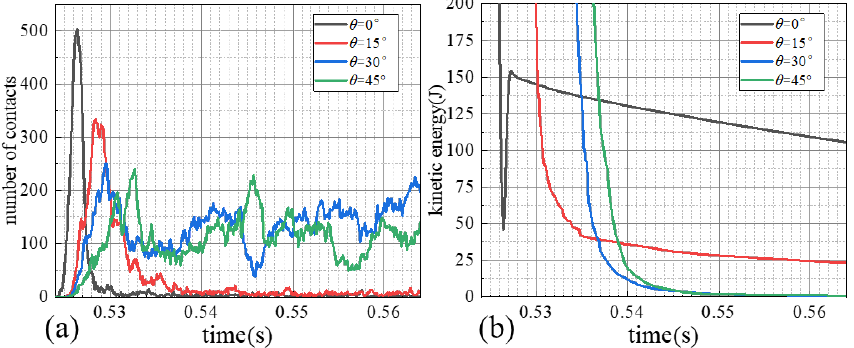
Figure 4. DEM simulation statistical results of the particle system under different baffle angle conditions. ( a ) changes in particle contact number; ( b ) changes in kinetic energy of the system.